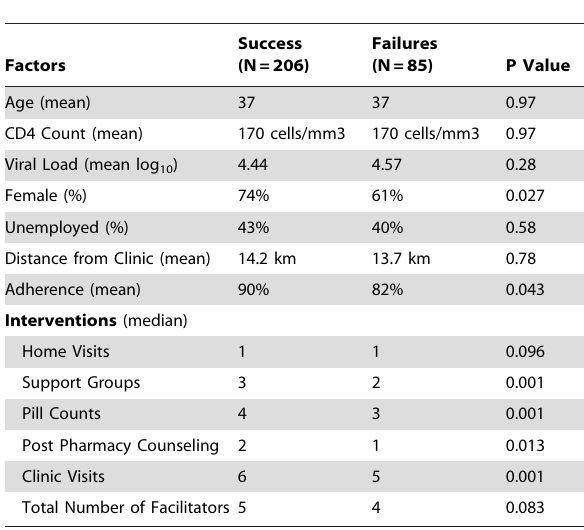
Table 2. Comparisons of Treatment Success and